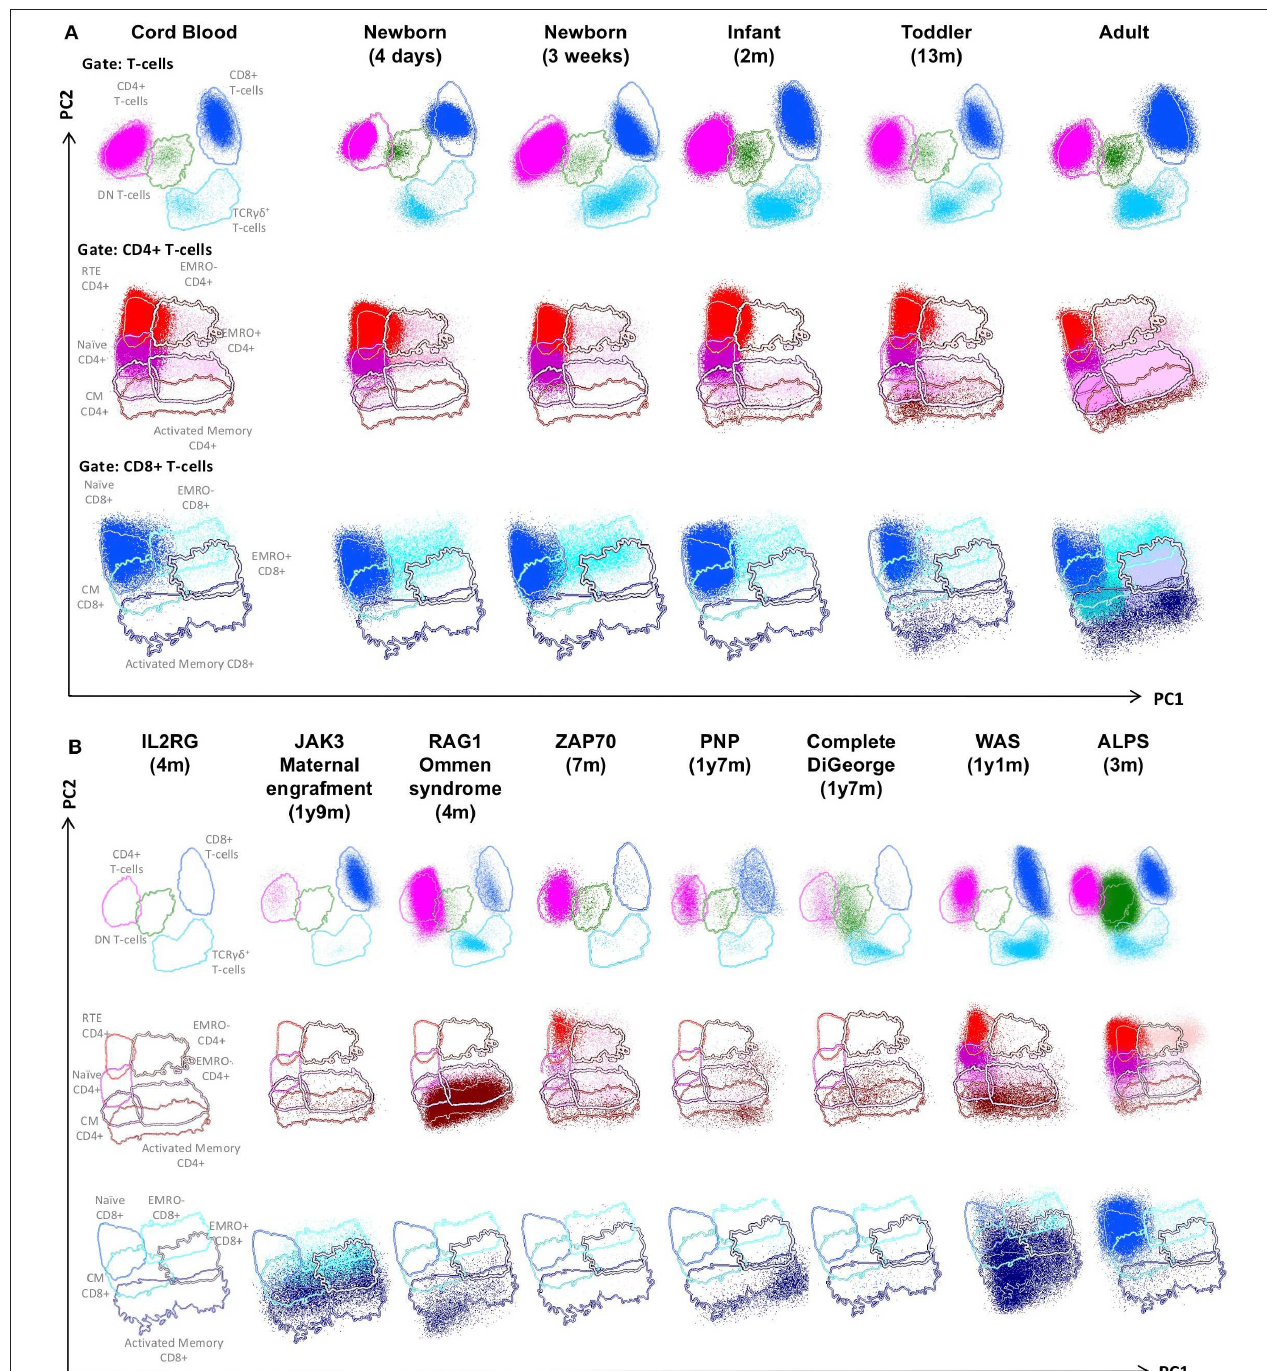
FIGURE 2 | PCA representation of SCID-RTE tube results, showing the distinct blood T-cell subsets in the supervised PCA analysis of blood samples from healthy donors of different age (A) and SCID and CID patients (B) . From the top down, APS plots of gated total, CD4 + and CD8 + T-cells are shown. Lines depict a 2 standard deviation boundary of all controls combined. (A) PCA (APS views) of all T-cell subsets of cord blood and peripheral blood from donors of different age. (B) PCA (APS views) of all T-cell subsets of the following patients: a IL2RG-deficient patient, a JAK3-deficient patient with maternal engraftment, a RAG1-deficient Omenn syndrome, a ZAP70-deficient patient, a PNP-deficient patient, a complete DiGeorge syndrome, a Wiskott-Aldrich syndrome (WAS) and an autoimmune lymphoproliferative syndrome (ALPS) patient.